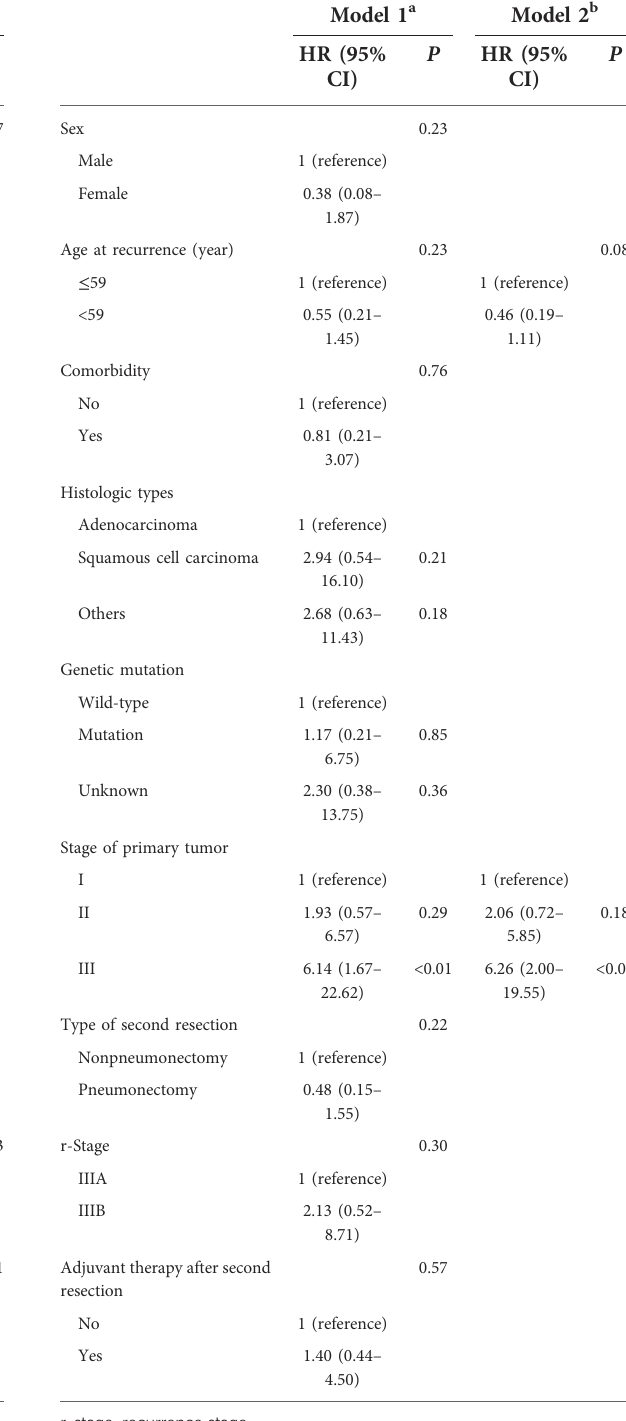
TABLE 3 Cox proportional hazards regression model showing the association of variables with PRS.